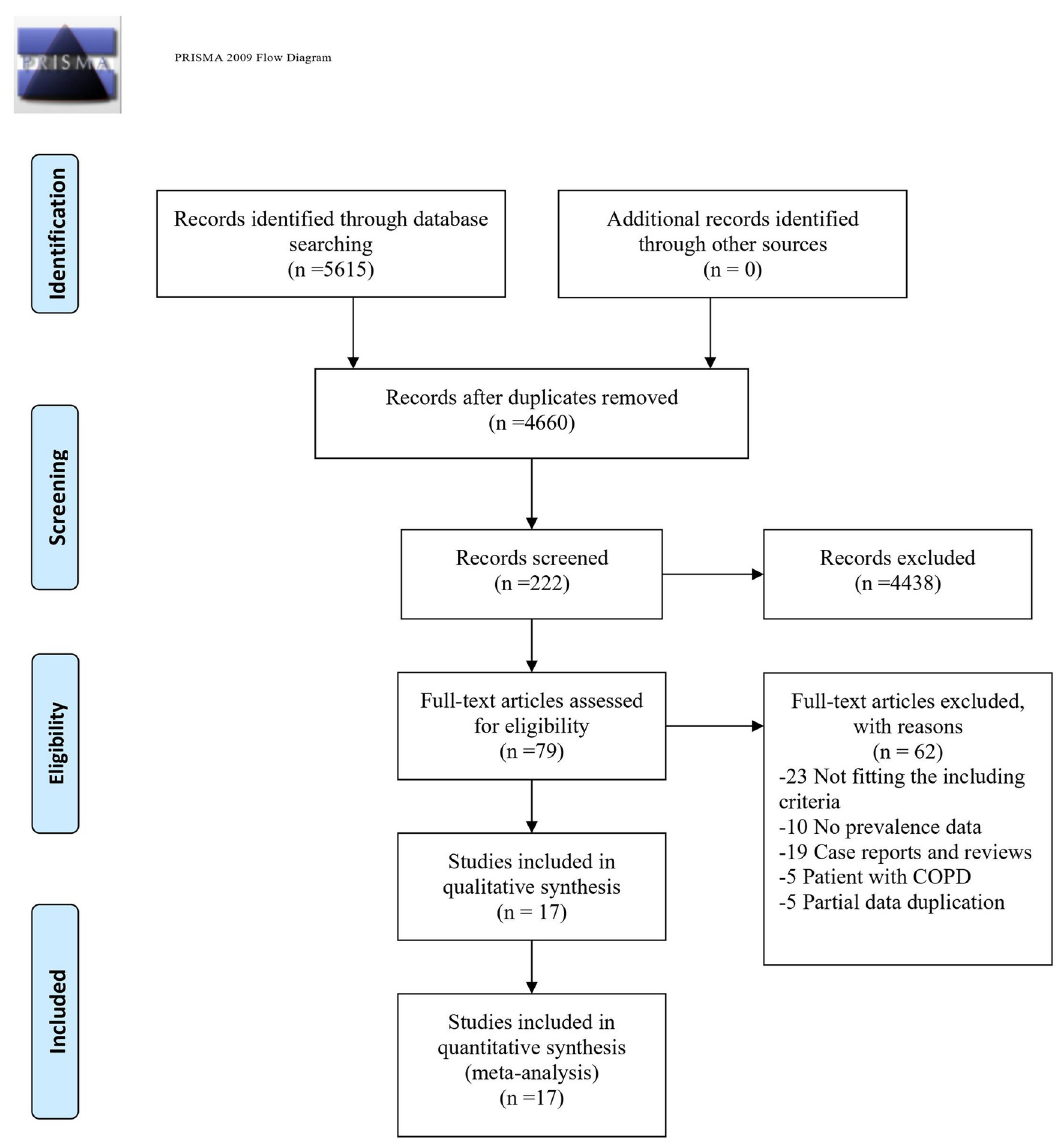
Fig 1. Flow diagram of the study selection process for the meta-analysis. From : Moher D, Liberati A, Tetzlaff J, Altman DG, The PRISMA Group (2009). P referred R eporting I tems for S ystematic Reviews and M eta- A nalyses: The PRISMA Statement. PLoS Med 6 (7): e1000097. doi:10.1371/journal.pmed.1000097 For more information, visit www.prisma-statement.org.